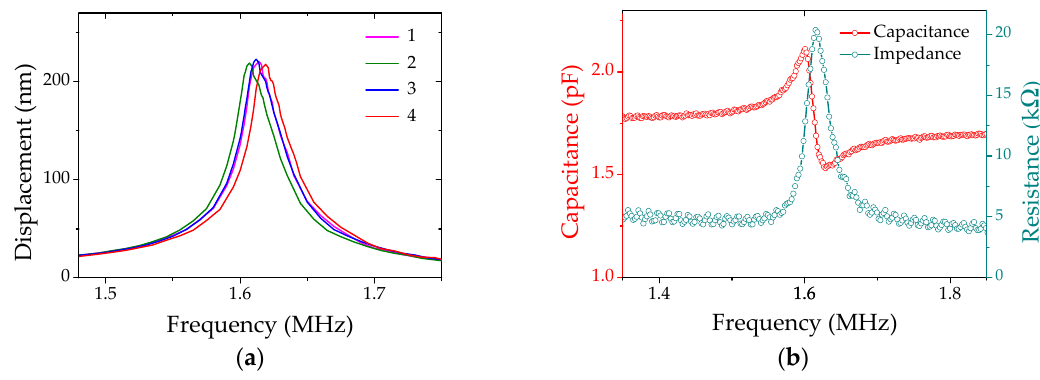
Figure 8. ( a ) Frequency dependence of surface displacements of four 100 μ m PMUTs. The resonance frequencies are narrowly distributed with a very small variation of ~0.7%. ( b ) Impedance measurement of a single 100 um PMUT with a very high coupling coefficient of k 2 t =